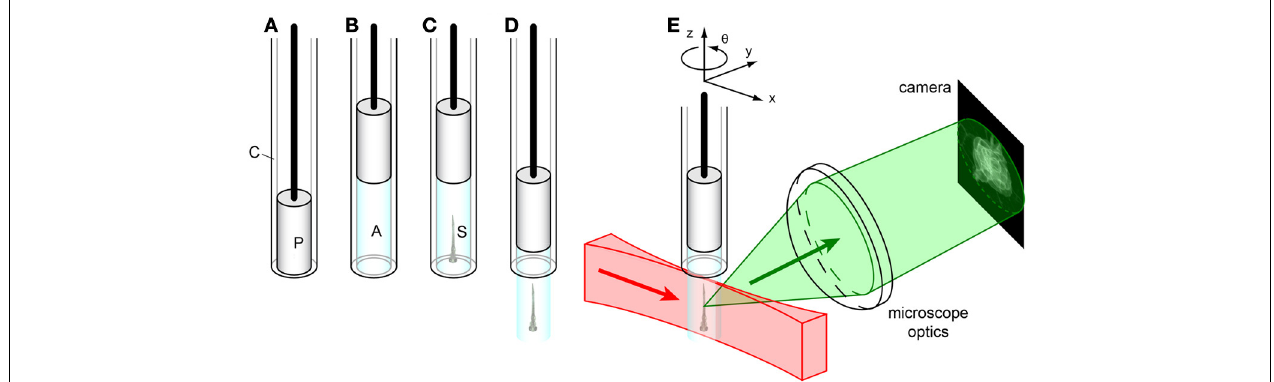
FIGURE 4 | Sample mounting for SPIM imaging. (A) Glass capillary (C) with plunger (P). (B) The plunger is pulled back, drawing liquid agarose (A, cyan) into the capillary. (C) Before the agarose solidifies, the sample (S) is carefully injected into the liquid agarose in the capillary by using a p20-pipette and a yellow tip cut in the end. (D) After the agarose solidifies, the plunger is